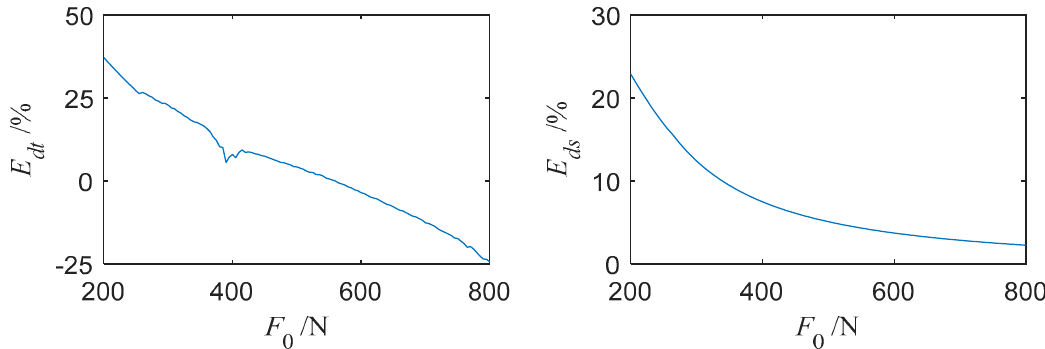
Figure 15. The influence of external excitation amplitude on the vibrational power reduction.